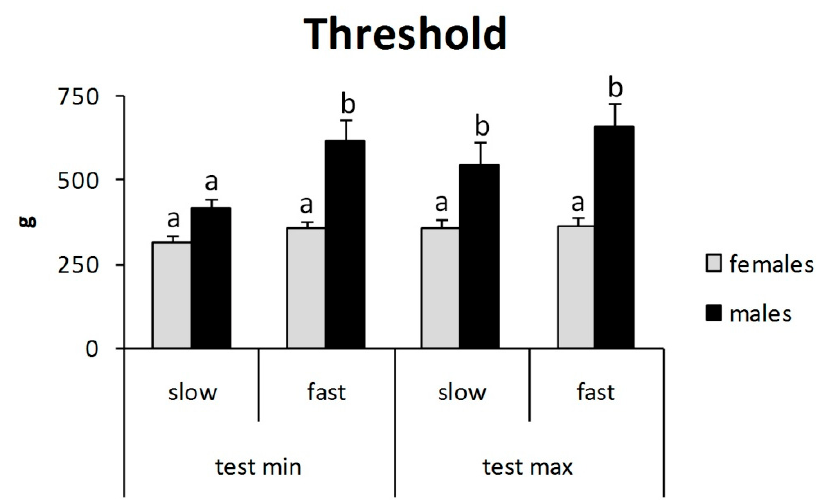
Figure 3. Autoalgometric threshold: gender differences.